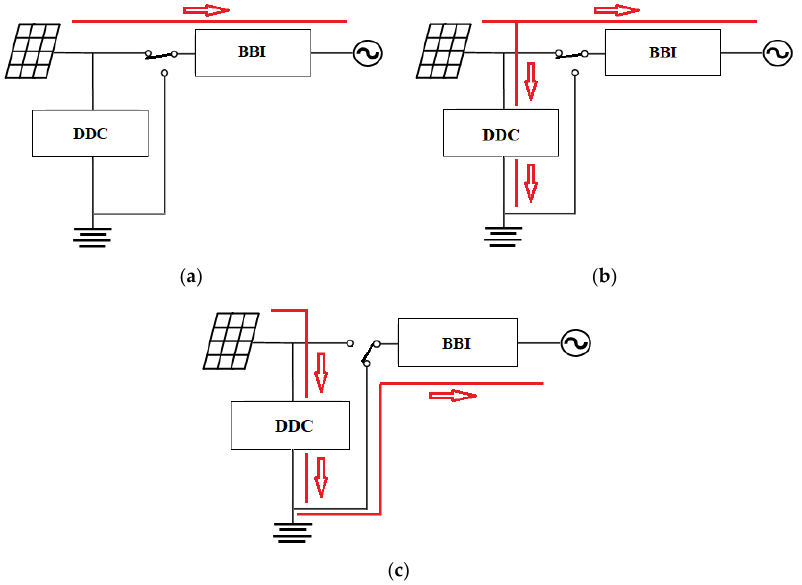
Figure 2. Power circuit of the proposed power conversion interface.